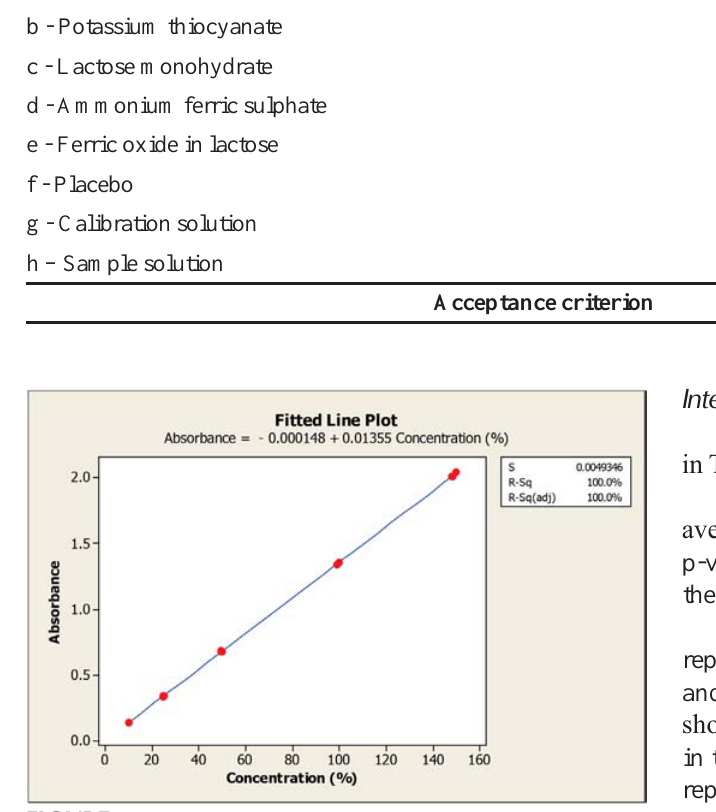
FIGURE 2 - The linearity of the procedure for concentrations from 10% to 150% (in relation to a 11.2 µg/mL